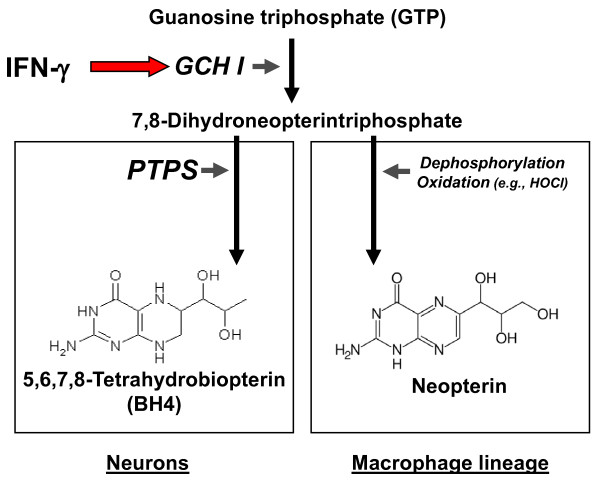
Induction of neopterin formation in brain cells. Pro-inflammatory cytokines like interferon-γ (IFN-γ) induce expression of GTP-cyclohydrolase I in various brain cells. As an intermediate product 7,8-dihydroneopterin-triphosphate is produced which is further converted by pyruvoyl-tetrahydropterin synthase (PTPS) to form 5,6,7,8-tetrahydrobiopterin (BH4), the cofactor of several aromatic amino acid monooxygenases that are involved in the production of tyrosine, L-DOPA, serotonin and nitric oxide. Different from neurons, monocytic cells possess only low constitutive activity of PTPS. Thus, 7,8-dihydroneopterin-triphosphate does not undergo conversion to BH4, rather it is dephosphorylated and oxidized to neopterin in non-enzymatic reactions.